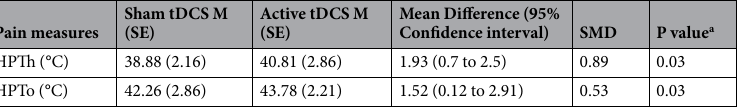
Table 4. Means and Standard Errors (SE) for the Secondary Outcomes (Heat Pain Threshold [HPTh] and Heat Pain Tolerance [HPTo]) according to Group (a-tDCS + Go/no-Go Task vs. s-tDCS + Go/no-Go Task) (n = 35). a Values based on a mixed ANOVA model. Significance level was P < 0.05.